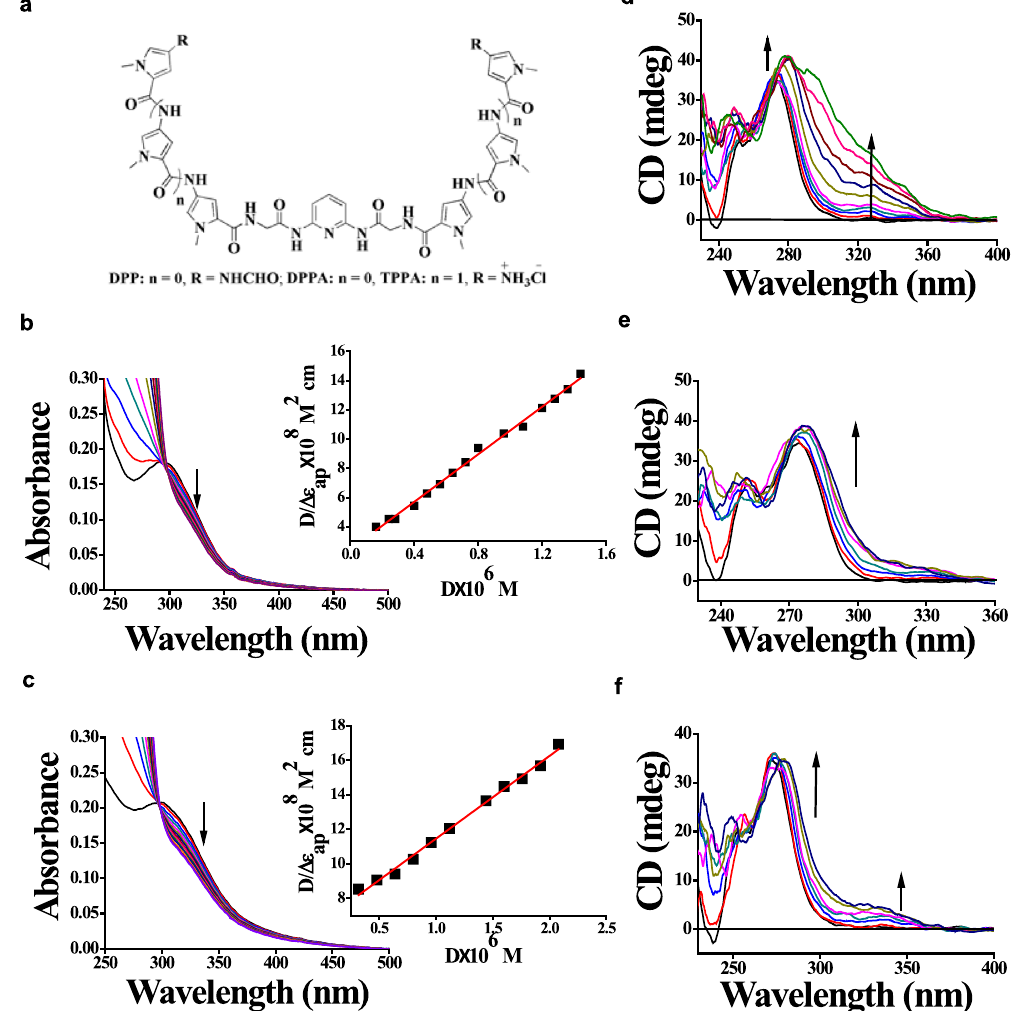
Figure 1. Binding data of various drugs to 5 ′ -TTAGG-3 ′ repeats. ( a ) Molecular structures of DPP , DPPA and TPPA . UV-Vis absorption spectral titrations of 20 μ M of ( b ) DPPA and ( c ) TPPA with increasing concentration of Bm -dup 20 with half-reciprocal plots as inset. CD titrations of Bm -dup 20 were performed with increasing aliquots of ( d ) DPP ( e ) DPPA and ( f ) TPPA in sodium phosphate (20 mM), NaCl (20 mM) buffer (pH 7.0) at 25